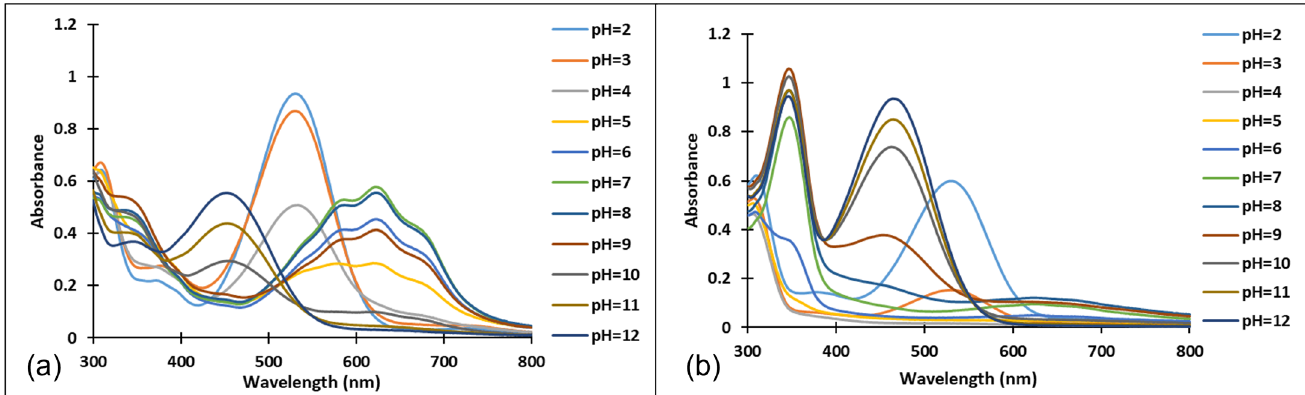
Figure 4. Absorption spectra of the species derived from compound 3, after ( a ) 40 min and ( b ) 72 h, at different pH values.